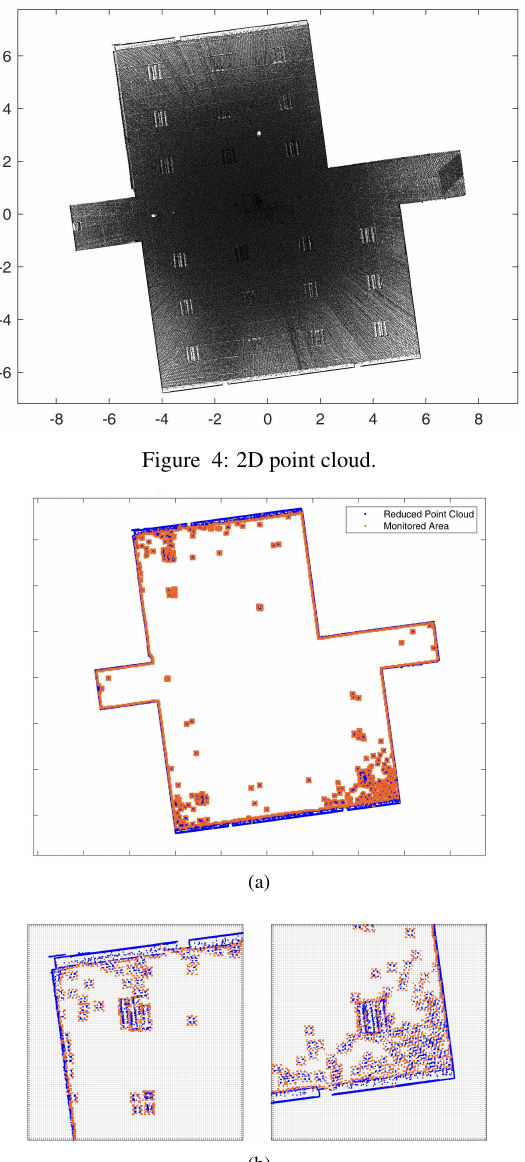
Figure 5: Reduced point cloud and monitored area for l s = 3 cm: (a) overview, (b) details.